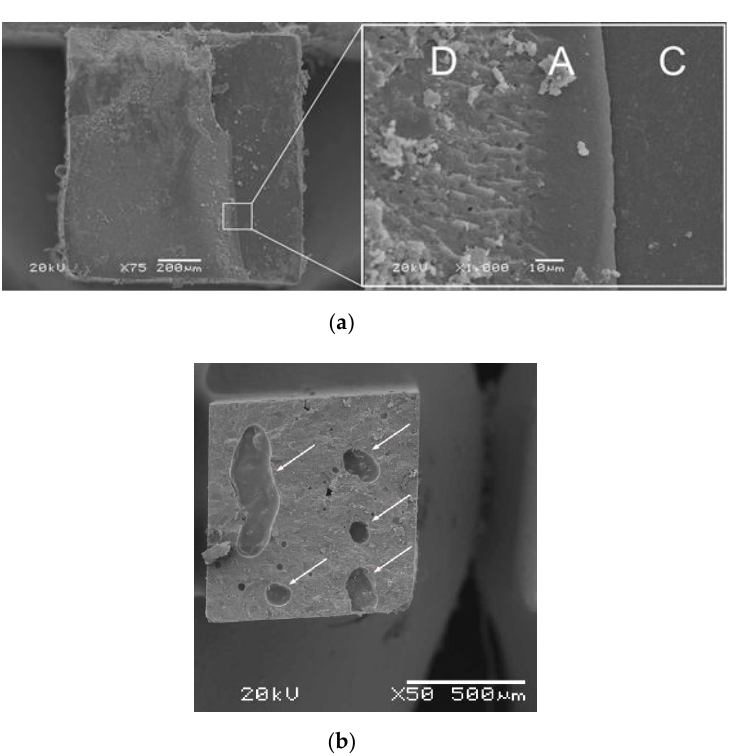
Figure 3. ( a ) Scanning electron microscope (SEM) micrographs (×75 and ×1000) of mixed failures